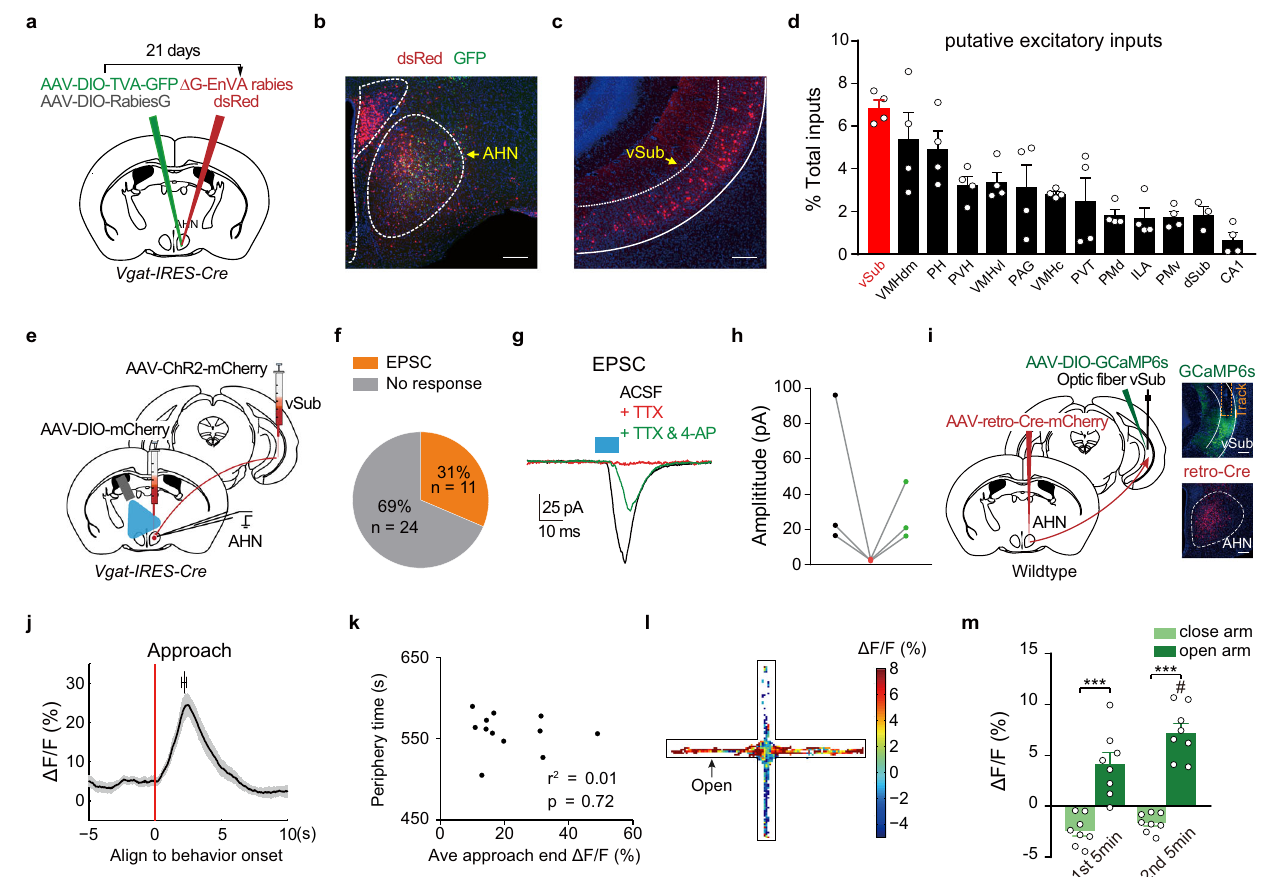
Fig. 6 | Hippocampal formation sends monosynaptic excitatory inputs to AHN Vgat+ neurons. a – d Retrograde tracing of inputs to AHN Vgat+ neurons. a Schematics ofthe viralstrategy. b , c Arepresentative imageshowinginfection of AHN Vgat+ neurons by AAV-DIO-TVA-GFP and EnVA-pseudotyped rabies virus expressing dsRed ( b ), and retrograde-labeled dsRed+ cells in vSub ( c ). Scale bar, 200 μ m. d Quanti fi cation of dsRed+ neurons in candidate excitatory brain areas as the percentage of total dsRed+ cells detected outside AHN. Each circle represents data from one animal. n =4miceexceptfor dSub. e – h Validationof vSub inputs to AHN Vgat+ neurons as monosynapticand excitatory via patchclamp. e Schematicsof the viral and electrophysiological recording strategy to probe vSub inputs to AHN Vgat+ neurons. f The number and percentage of recorded neurons that showed light-evoked EPSC. n =35 cells from 6 animals. g , h Example traces ( g ) and quan- ti fi cations ( h ) of light-evokedEPSC in AHN Vgat+ neurons under different conditions. Blue bar indicating light pulse stimulation (10ms). i – m Recording the activity of